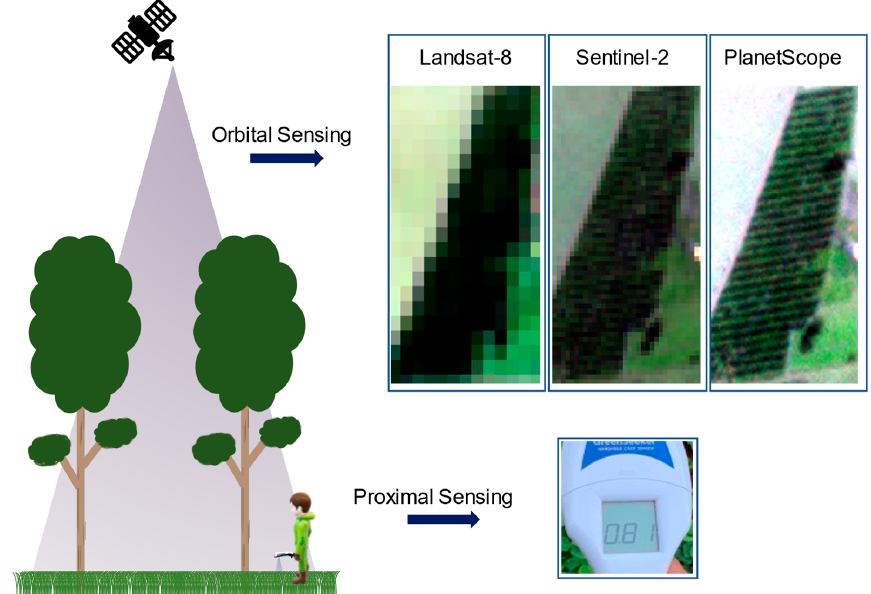
Figure 1. Use of orbital and proximal remote sensing in silvopastoral systems. These models are being increasingly used in studies that aim to estimate biomass and productivity of crop areas. [14,15] demonstrated that the SAFER model is promising for estimating corn and pasture biomass. [16] found that the model has high applicability for estimating biophysical parameters and energy balance in Urochloa brizantha cv. Marandu. However, this model has not yet been used to estimate forage mass in a silvopastoral system. Several biophysical parameters, such as the vegetation index (VI) and fractions derived from spectral mixture analysis [17], evapotranspiration [18], and energy balance components [16], have been used to characterize pasture grazing systems. Thus, the aim of this study was to analyze the feasibility of SAFER as a model for estimating the biophysical parameters of Urochloa brizantha cv. Piatã in different pasture production systems. Proximal reflectance and meteorological data were used as input data in the SAFER agrometeorological model combined with the Monteith radiation use efficiency (RUE) model. 2. Materials and Methods 2.1. Study Site and Experiment Design The study was conducted in the experimental area of Embrapa Pecuária Sudeste, São Carlos, SP, Brazil (21°57 ′ S, 47°50 ′ W, 860 m; Figure 2). According to Koppen’s classification, the region is characterized by a Cwa climate (humid subtropical climate) composed of a dry winter and rainy summer [19]. The soil in the study area is the dystrophic red-yellow latosol [20]. In the study site, 2 grazing systems were evaluated: a silvopastoral system (SILV) and an intensive (INT), full-sun system, with Urochloa pasture (syn. Brachiaria) brizantha cv. BRS Piatã, in rotational grazing. Eucalyptus trees (Eucalyptus urograndis clone GG100) were planted in the SILV system in April 2011. The experimental design consisted of single rows, with an orientation close to east-west in a spacing of 15 × 2 m (15 m between rows and 2 m between trees in the rows), which resulted in a population density of 333 trees ha-1.